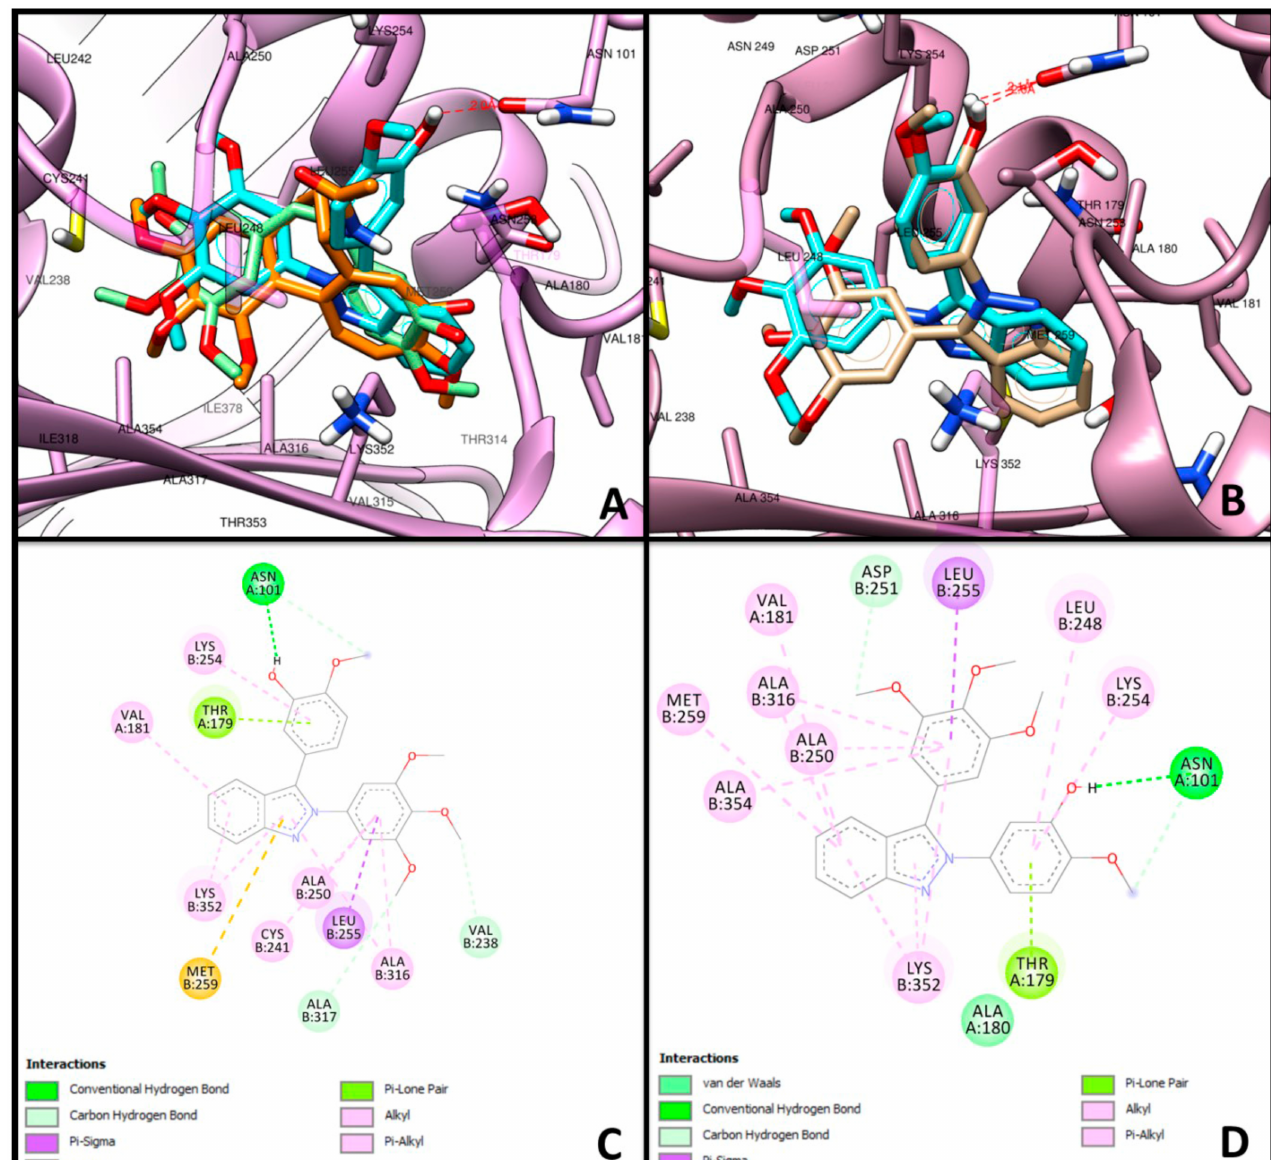
Figure 2. Molecular coupling of compounds 5 and 6 at the colchicine site on beta-tubulin. ( A ) Binding mode of colchicine (orange), CA-4 (green) and compound 5 (cyan) docked into the colchicine binding site cavity (lilac) (PDB: 5LYJ). ( B ) Binding mode of compound 5 (cyan) and 6 (khaki) docked into the colchicine binding site cavity. 2D diagram of docked compounds 5 ( C ) and 6 ( D ) into the colchicine binding site cavity showing their interaction with the binding site